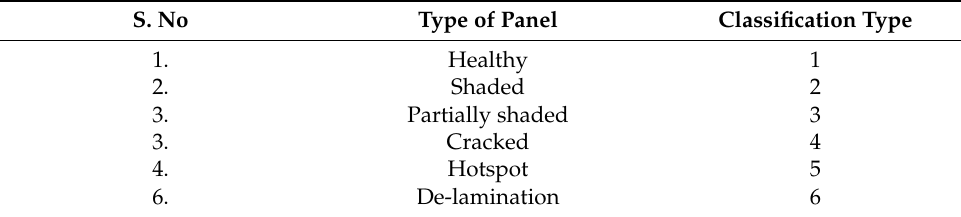
Table 6. Fault classification details of NN.